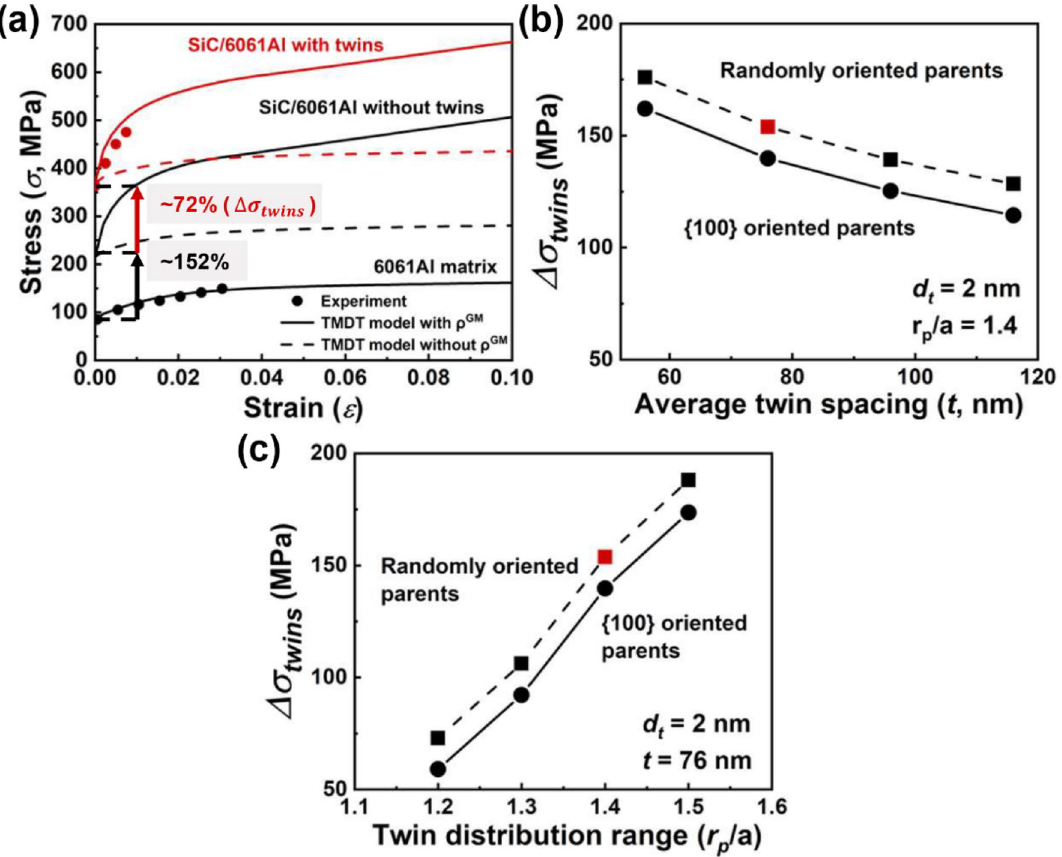
Figure 7. The mechanical stress–strain responses calculated by the VPSC-TMDT model with thermal mismatch twins. ( a ) Compared to the SiC/6061Al composites with and without twins, the mechanical properties of the composites after embedding twins are significantly enhanced. ( b , c ) Mechanical strength of the composites is less influenced by parent texture, but strong dependent on the twin spacing ( t ) and twin distribution range ( r p / a